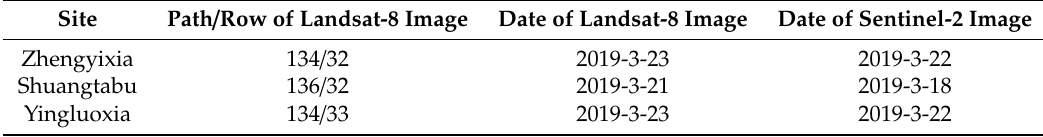
Table 1. Landsat-8 and Sentinel-2 images used in this study. Table 1. Landsat ‐ 8 and Sentinel ‐ 2 images used in this study.